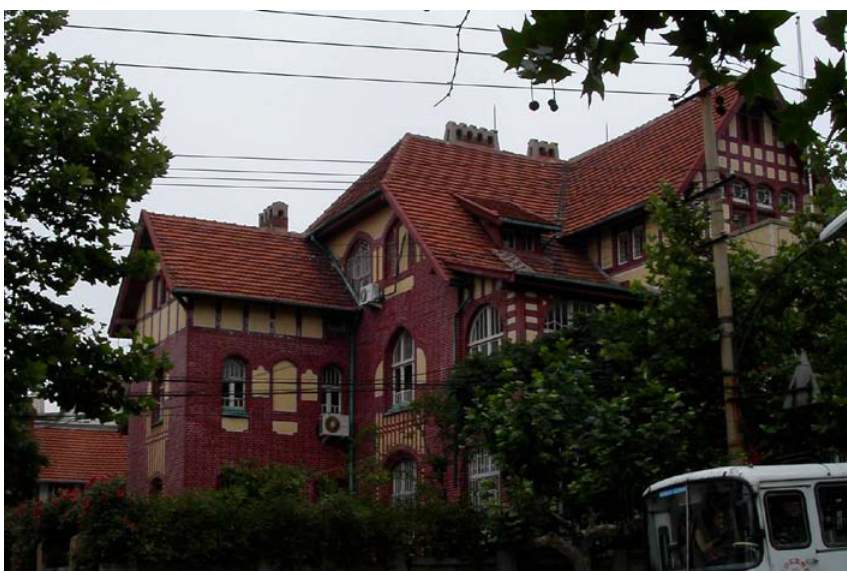
Figs. 3 (above) and 4 (below): Qingdao’s German colonial architecture was a stark contrast with the Asian features of Tanxu’s